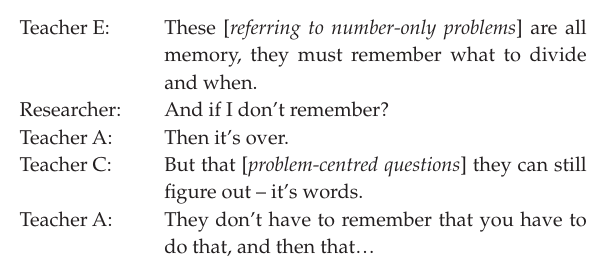
Table 2 reflects a summary of the lessons observed.